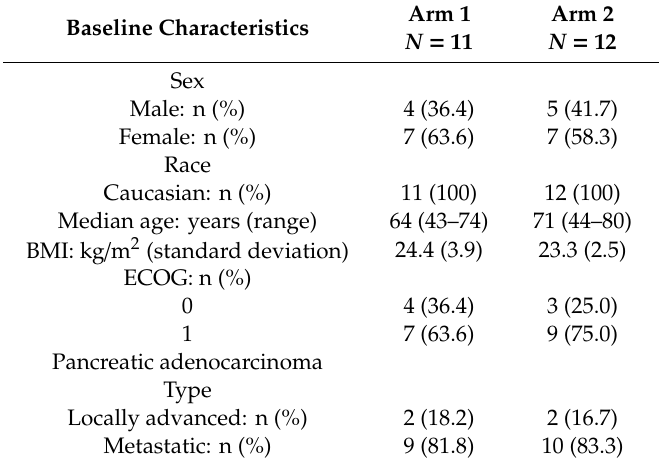
Table 1. Baseline characteristics of subjects randomized to the treatment period (Safety analysis set, N = 23). Baseline Characteristics